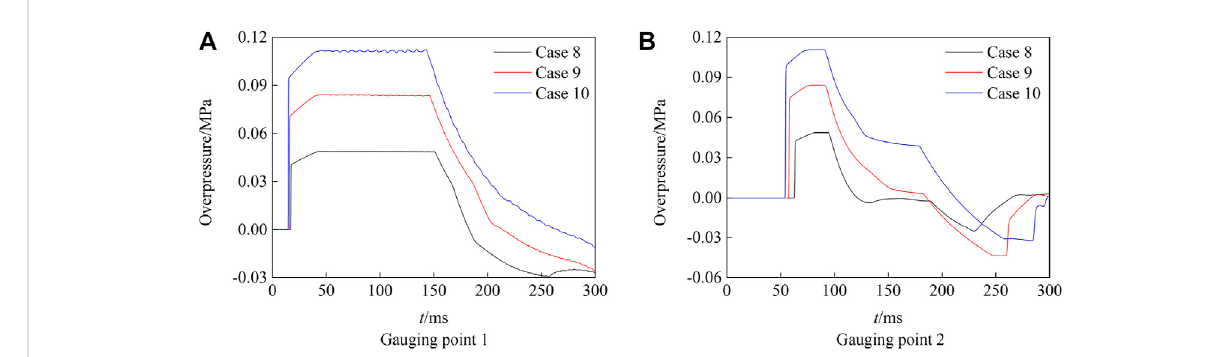
Wave system contour of space-time of case 15 (combined-driven